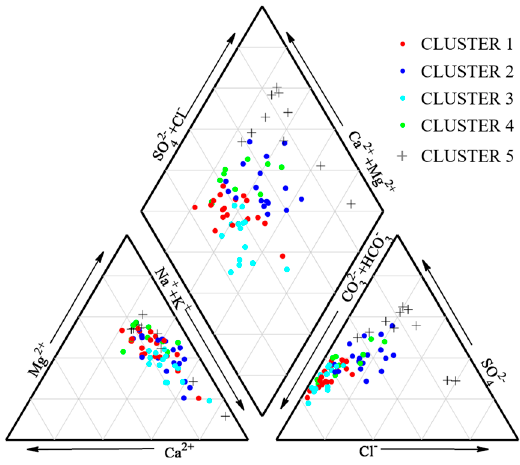
Figure 4. The Piper diagram for the groundwater samples.